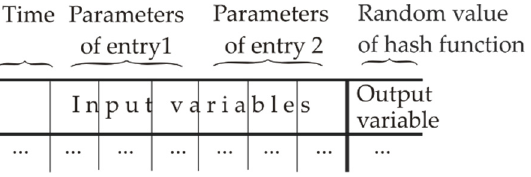
Figure 5. Principle of formation of the ledger function with two linked entries 1 and 2 obtained at different time moments.